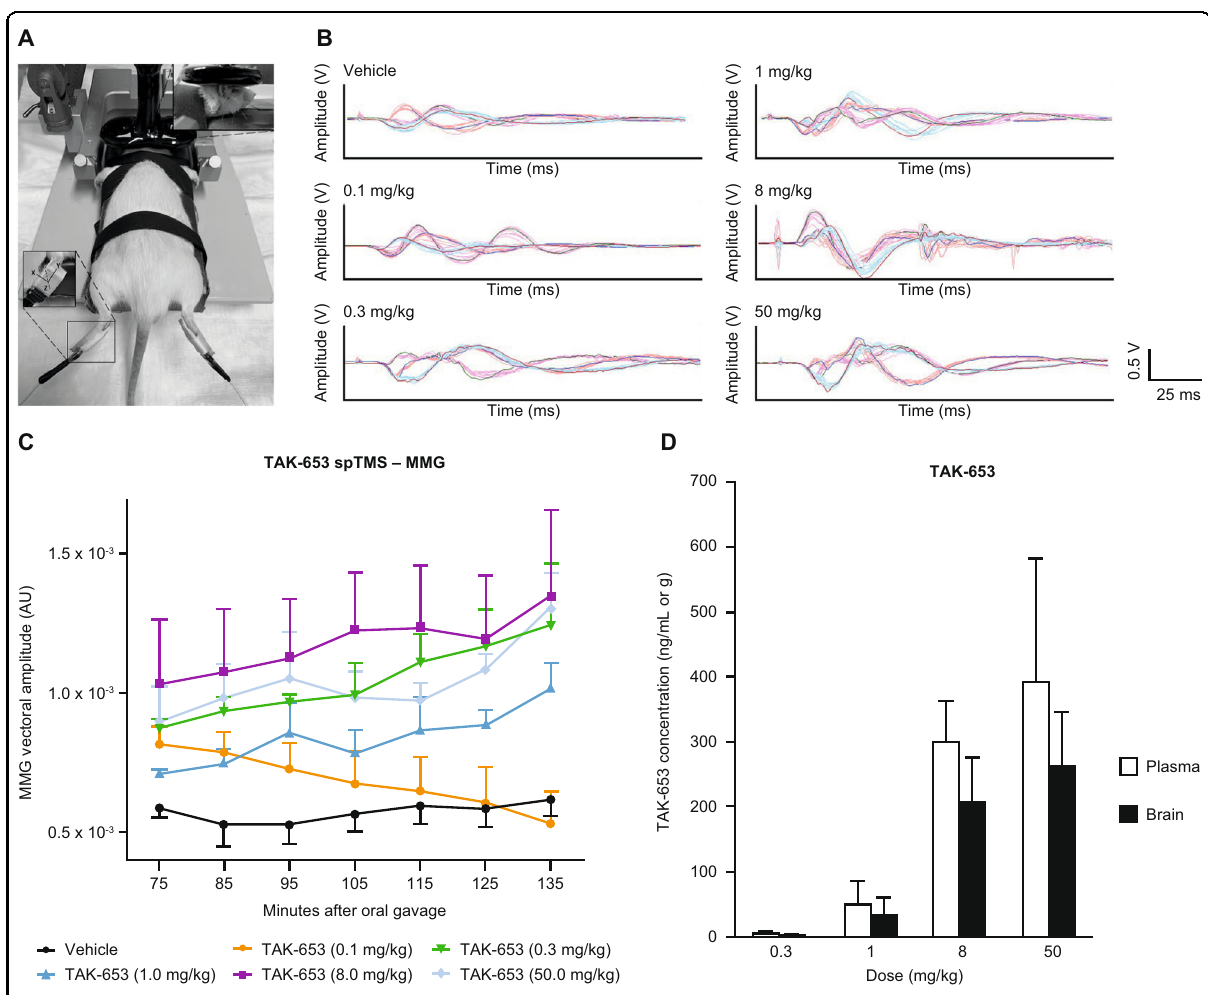
Fig. 1 TAK-653 enhanced TMS-evoked motor responses in rats. A Example of an animal placement on the stereotaxic apparatus, a small fi gure- eight coil, and an accelerometer attached to the hind paws. B Representative waveforms in three dimensions (pictured in different colors) used for MMG calculation with vehicle or fi ve different doses of TAK-653. C Summary graph illustrating the MMG vectoral amplitude over time for all six treatment groups (mean ± SEM). All TAK-653 doses except for 0.1 mg/kg increased MMG amplitude. No dose – response effect was observed. D Plasma and brain TAK-653 levels 2 h after administration via oral gavage in rats with the four effective doses. MMG, mechanomyography; spTMS, single-pulse transcranial magnetic stimulation; TMS, transcranial magnetic